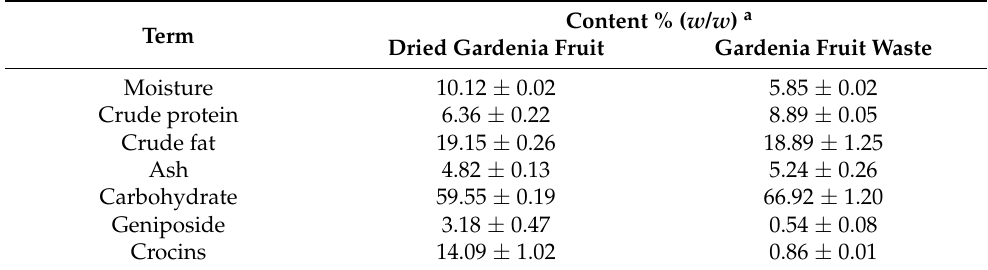
Table 1. Proximate composition, geniposide, and crocins analyses in the dried gardenia fruits and gardenia fruit